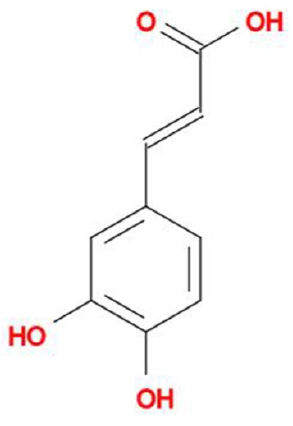
Figure 1. Chemical structure of caffeic acid.